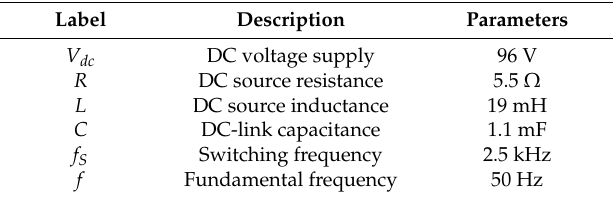
Table 2. Experimental setup parameters.